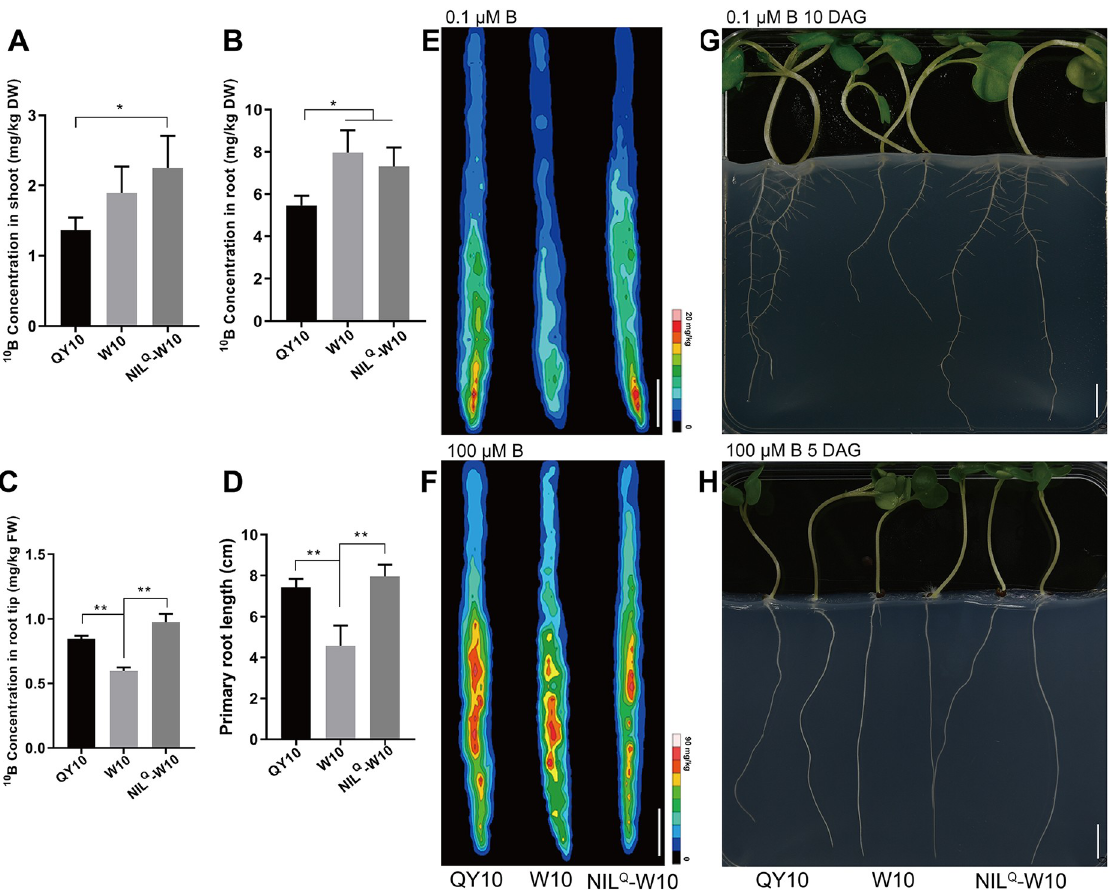
Fig 3. BnaA3.NIP5;1 transports B into the root tips to promote root growth. ( A-C ) 10 B concentrations in the shoots ( A ), roots ( B ) and root tips ( C ) of QY10, W10 and NIL Q -W10. In ( A and B ), QY10, W10 and NIL Q -W10 seedlings were pre-cultured with 25 μ M 11 B for 15 d and then exposed to a solution without B for 1 d. The seedlings were subsequently exposed to 10 μ M 10 B for 1 h. In ( C ), the seedlings were pre-cultured in solid media without B for 5 d, after which the root tips were covered by a piece of solid media consisting of 10 μ M 10 B for 1 h, with 50 to 60 root tips constituting one replicate. After HNO 3 digestion, 10 B and 11 B were determined by ICP-MS. ( D ) Primary root length of QY10, W10 and NIL Q -W10 seedlings grown on solid media consisting of 0.1 μ M B for 10 d. ( E and F ) 10 B distribution in the root tips of 5-d-old QY10, W10 and NIL Q -W10 under 0.1 μ M ( E ) and 100 μ M ( F ) B according to LA-ICP-MS. Roots of QY10, W10 and NILQ-W10 seedlings grown on solid media consisting of 0.1 μ M 10 B and 100 μ M 10 B conditions for 5 d. The root tips were put into the laser ablation chamber and scanned together with the standard reference materials; 10 B was determined by ICP-MS, and similar results were observed in each of three independent experiments. Scale bars, 100 μ m. ( G and H ) Morphology of QY10, W10 and NIL Q -W10 root